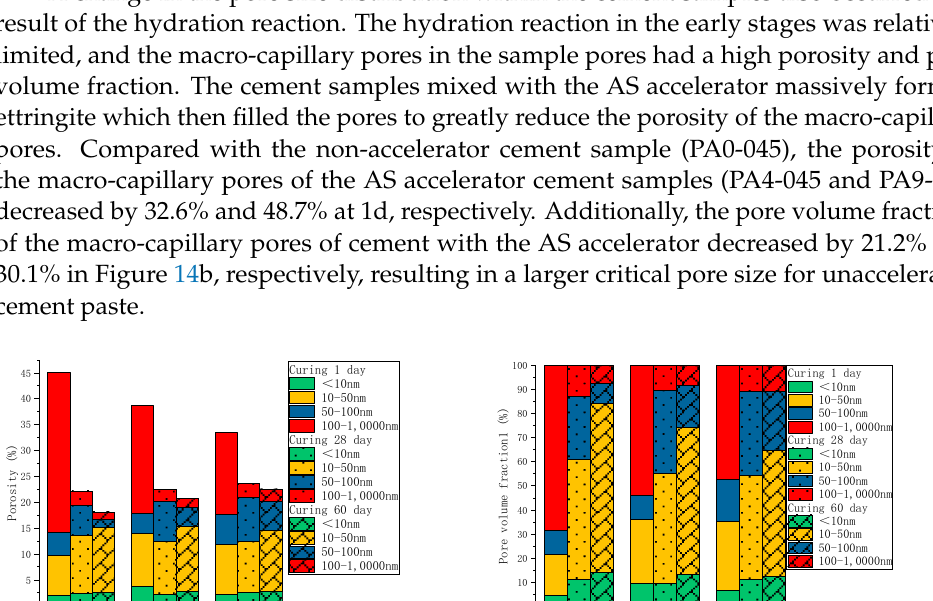
Figure 14. The pore distribution of hydrated cement pastes with different dosages of the AS accelerator: ( a ) the porosity; ( b ) the pore volume fraction.